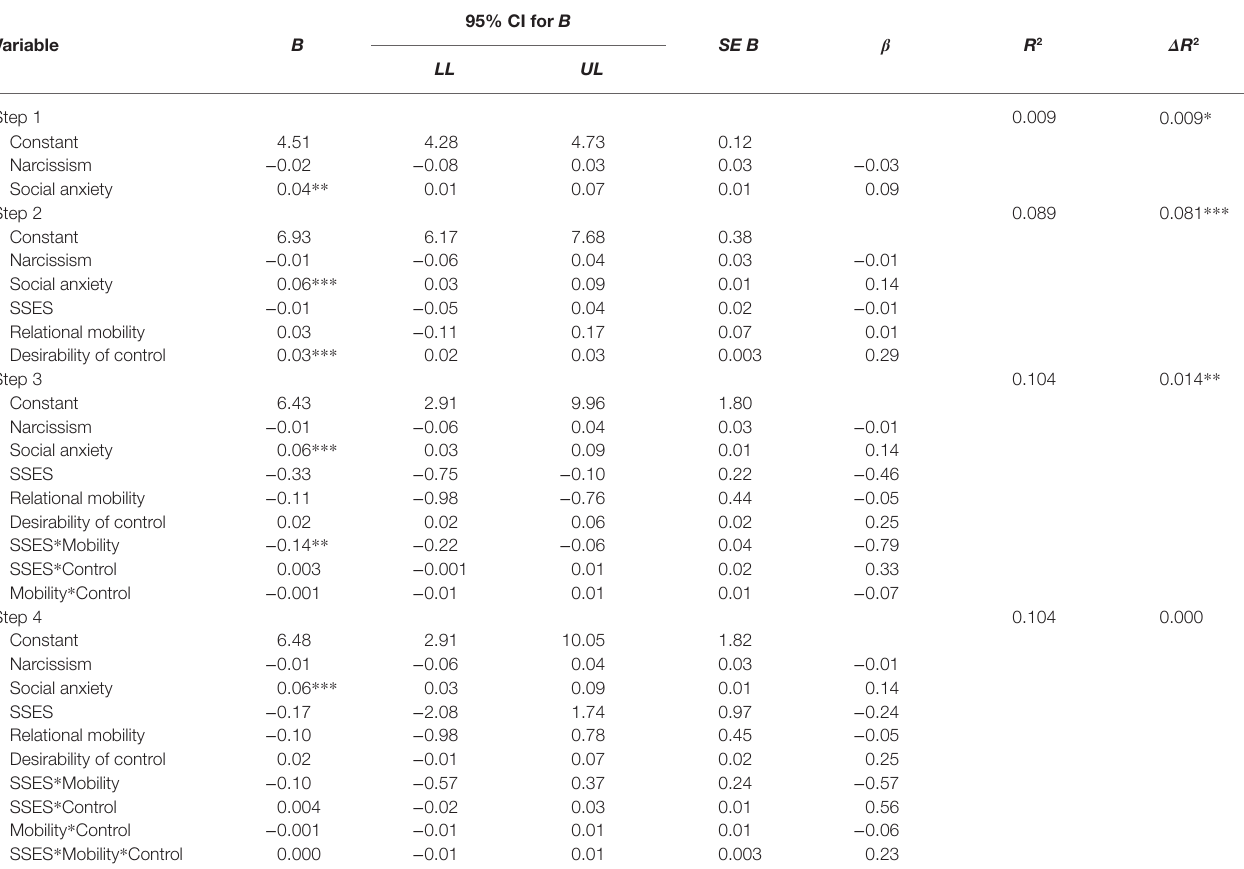
TABLE 4 | Hierarchical regression results for attitudes toward singlehood with interaction effect (single individual, N = 870). Variable